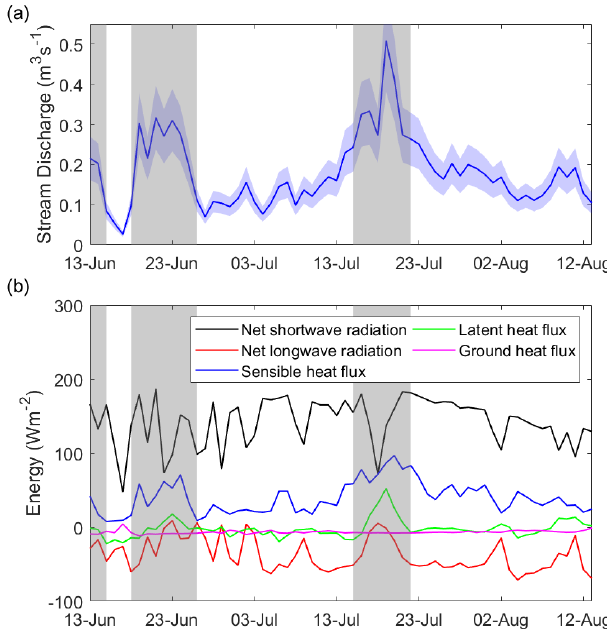
Figure 6. (a) Daily discharge calculated by averaging the hourly discharge from Fig. 5a. The uncertainty in the daily mean dis- charge generated by averaging hourly discharge, X dm , is shown in the blue-shaded area (see Appendix A for uncertainty calculations). (b) Surface energy components – net shortwave radiation (black), net longwave radiation (red), sensible heat flux (blue), latent heat flux (green), and ground heat flux (magenta). Large melt episodes are shown in grey-shaded